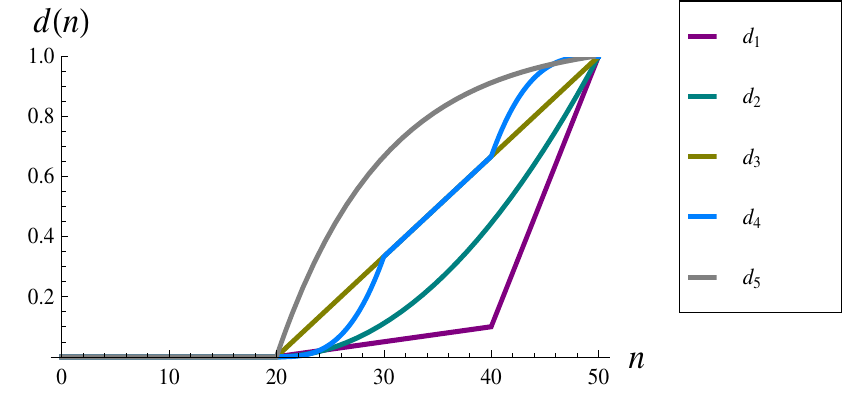
Figure 1. Dropping functions d 1 – d 5